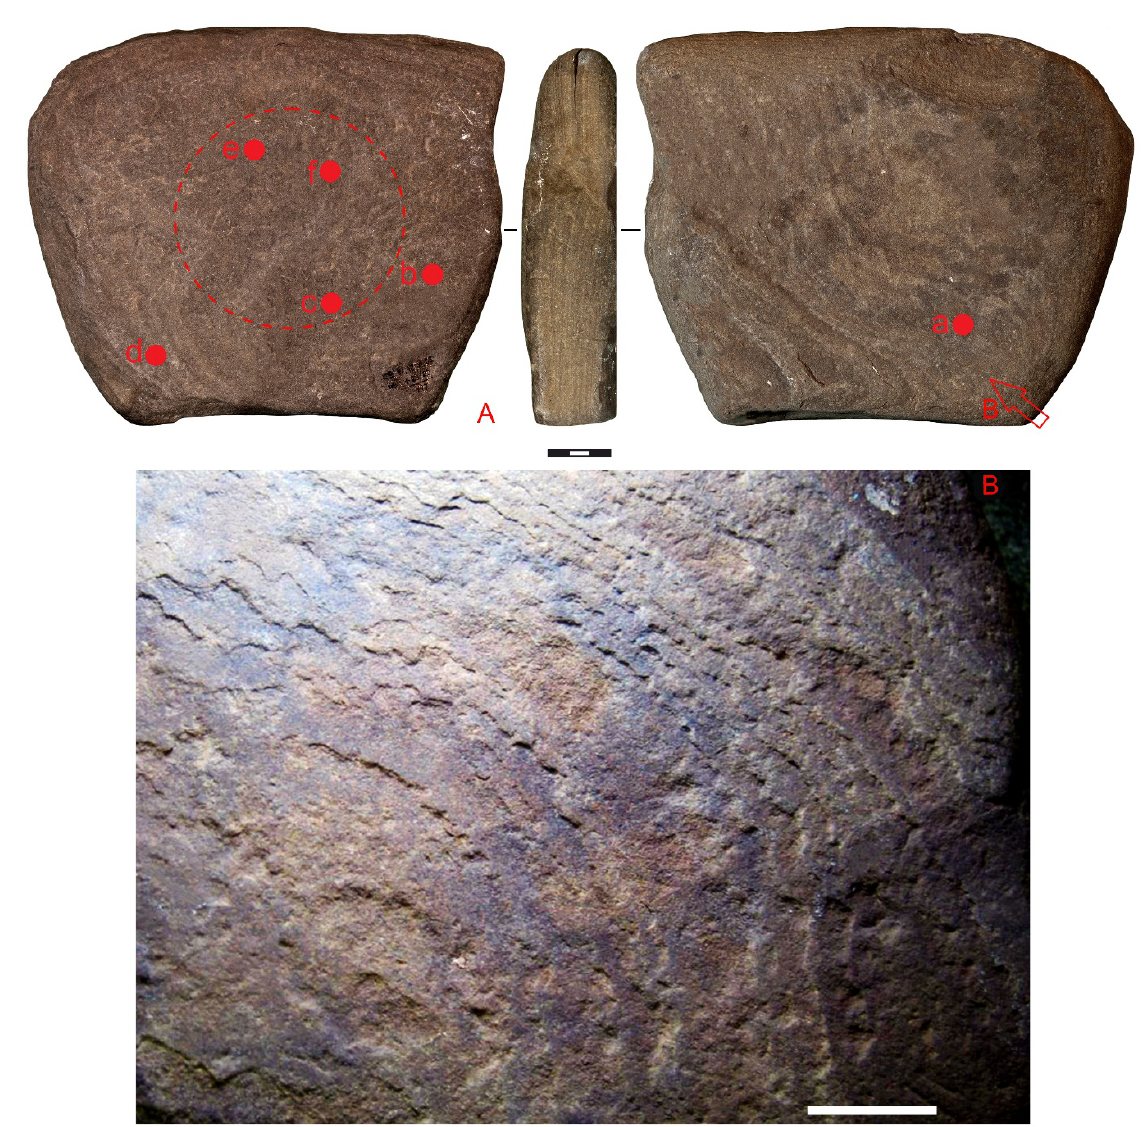
Figure 5. Slab from Kamennaya Balka II site (A): a to f spots where microphoto have been taken (see figure 6). The whole area of the slab was involved in the solubilization in the ultrasonic bath to extract use-related biogenic residues. B: spot and macrophoto of it of the lower deformade surface (scale bar = 1